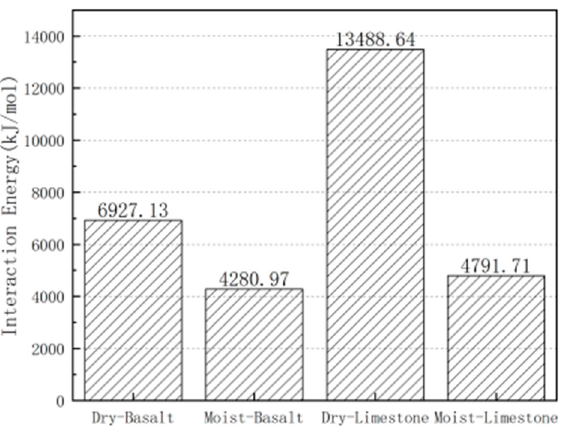
Figure 16. Influence of water on the asphalt–aggregate interaction energy.